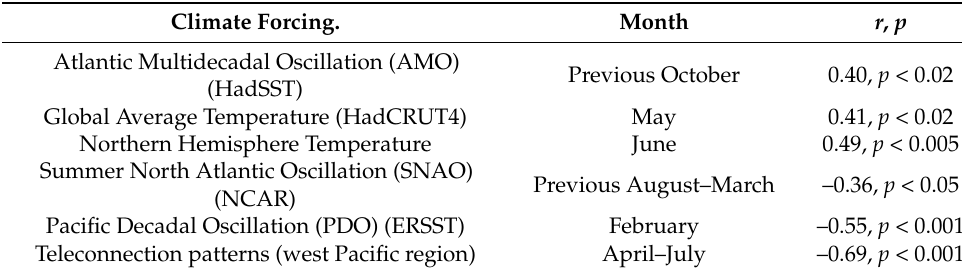
Table 6. The correlation between the CNDVI JJ and sea–atmospheric factors. The correlations be- tween the CW–DHM regional CNDVI JJ and large-scale sea–atmospheric factors in the Northern Hemisphere.